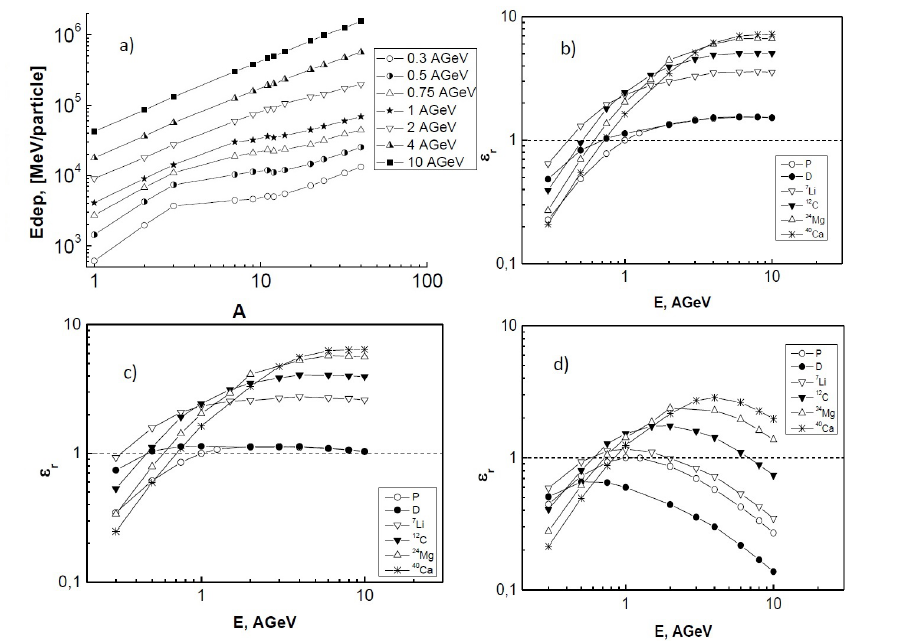
Figure 1. The energy released as function on the projectile type and energy (a), the relative e ffi ciency for beams accelerated in a synchrotron (b), linear accelerator (c), and cyclotron